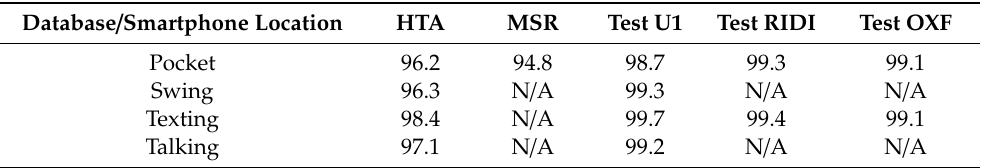
Table 9. Test accuracy results when training on the TrainROU dataset with the CNN architecture while using both accelerometer and gyroscope